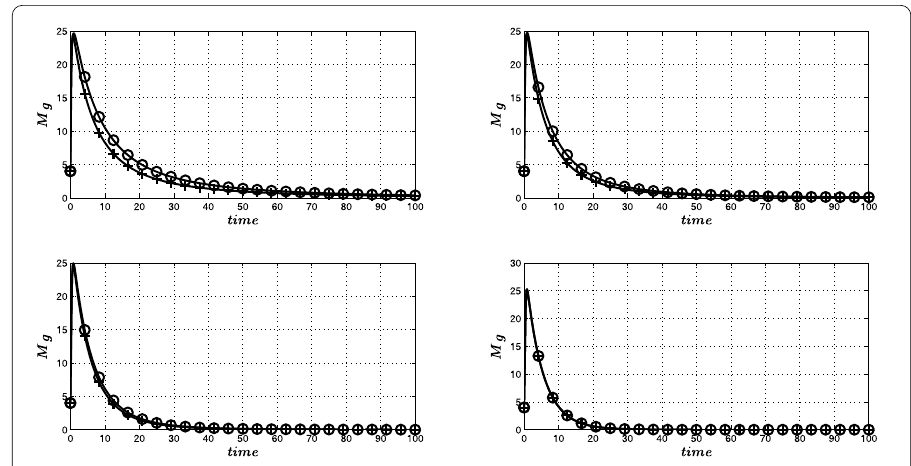
Figure 5 Asymptotic behaviour of M g within the classic Caputo derivative (+) and ABC fractional operator ( (cid:11) ) for different values of α . α = 0.85 (upper-left), α = 0.9 (upper-right), α = 0.95 (lower-left), α = 1 (lower-right)